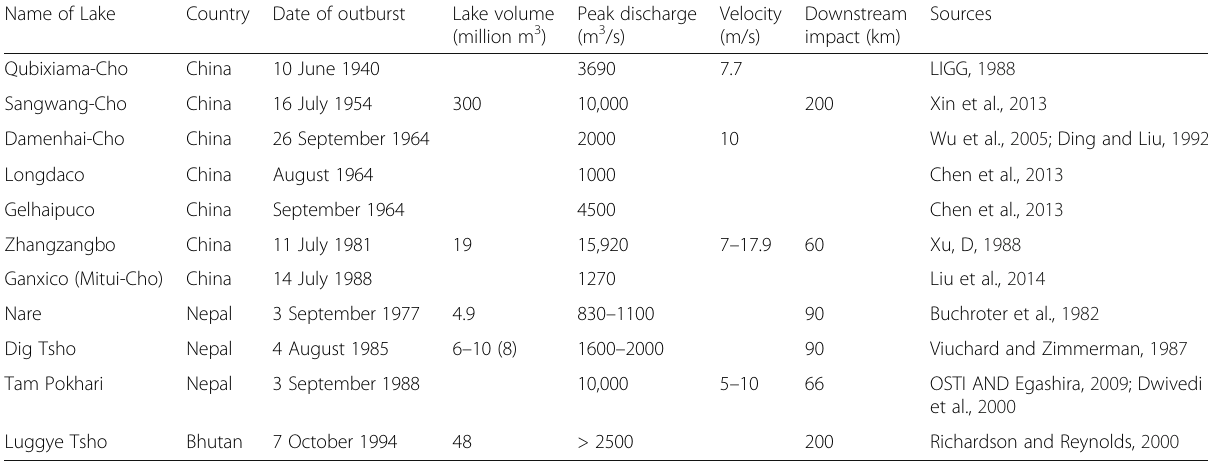
Table 1 Estimated peak discharge of GLOF and the distance to downstream sites where the GLOF events caused damages Name of